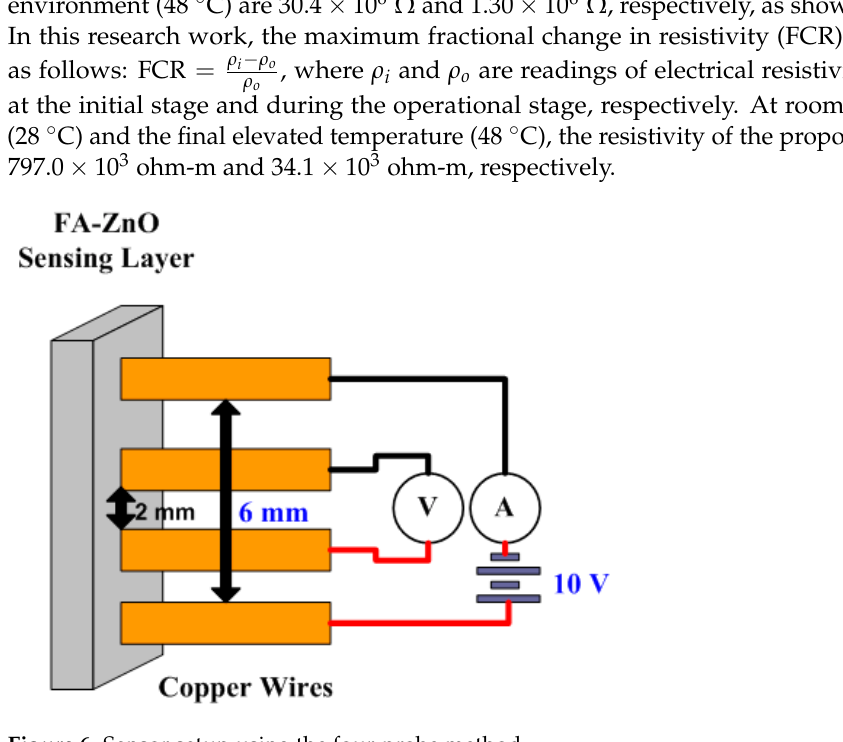
Figure 6. Sensor setup using the four-probe method.